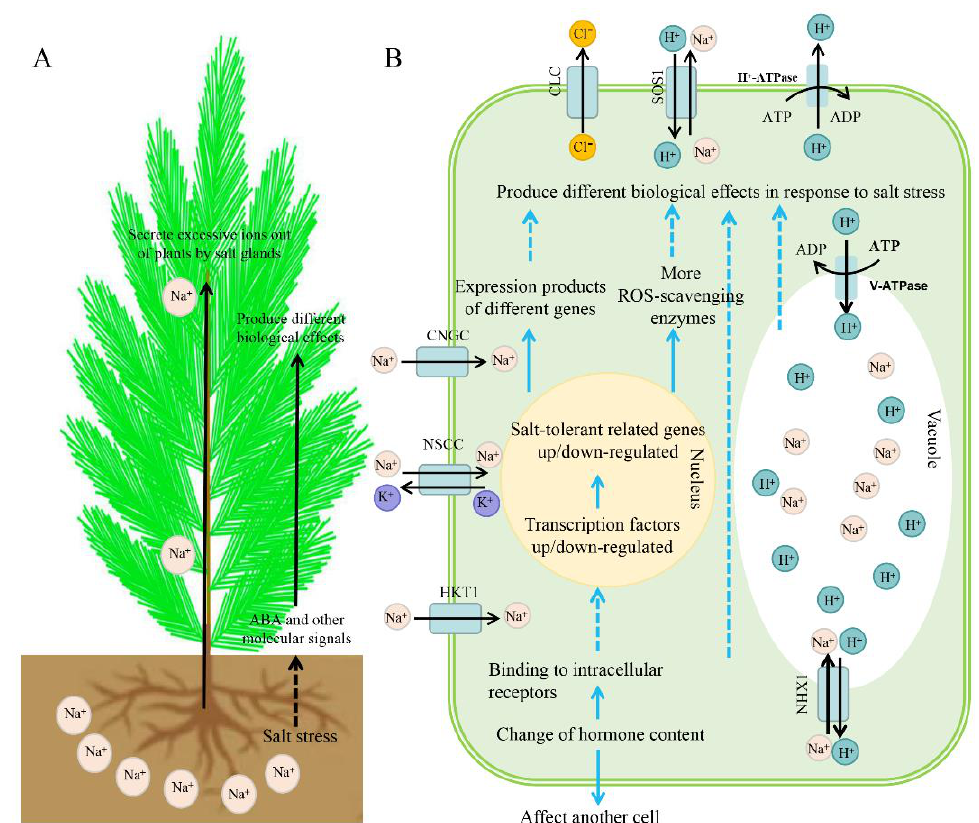
Figure 1. Strategies of tamarisk coping with salt stress. ( A ). The general strategies of tamarisk to deal with salt stress at the whole plant level. This involves the absorption of salt from roots and the removal of salt in the leaf by salt glands, as well as the transport of ABA and other signaling molecules from the roots to the aboveground under salt stress, ( B ). The general strategies of tamarisk in response to salt stress at the cellular level. Intracellular strategies for dealing with salt stress involve a complex regulatory network that helps cells reduce the damage caused by salt stress and remove salt from the cell to maintain normal physiological metabolism. In the figure, the solid line represents a direct effect, and the dotted line represents an indirect effect; CNGC, cyclic nucleotide-gated cation channel; NSCC, non-selective cation channel; CLC, chloride channel; HKT1, high-affinity potassium transporter; NHX1, tonoplast-located Na + /H + antiporter; SOS1, salt overly sensitive 1 (plasma membrane-located Na + /H +